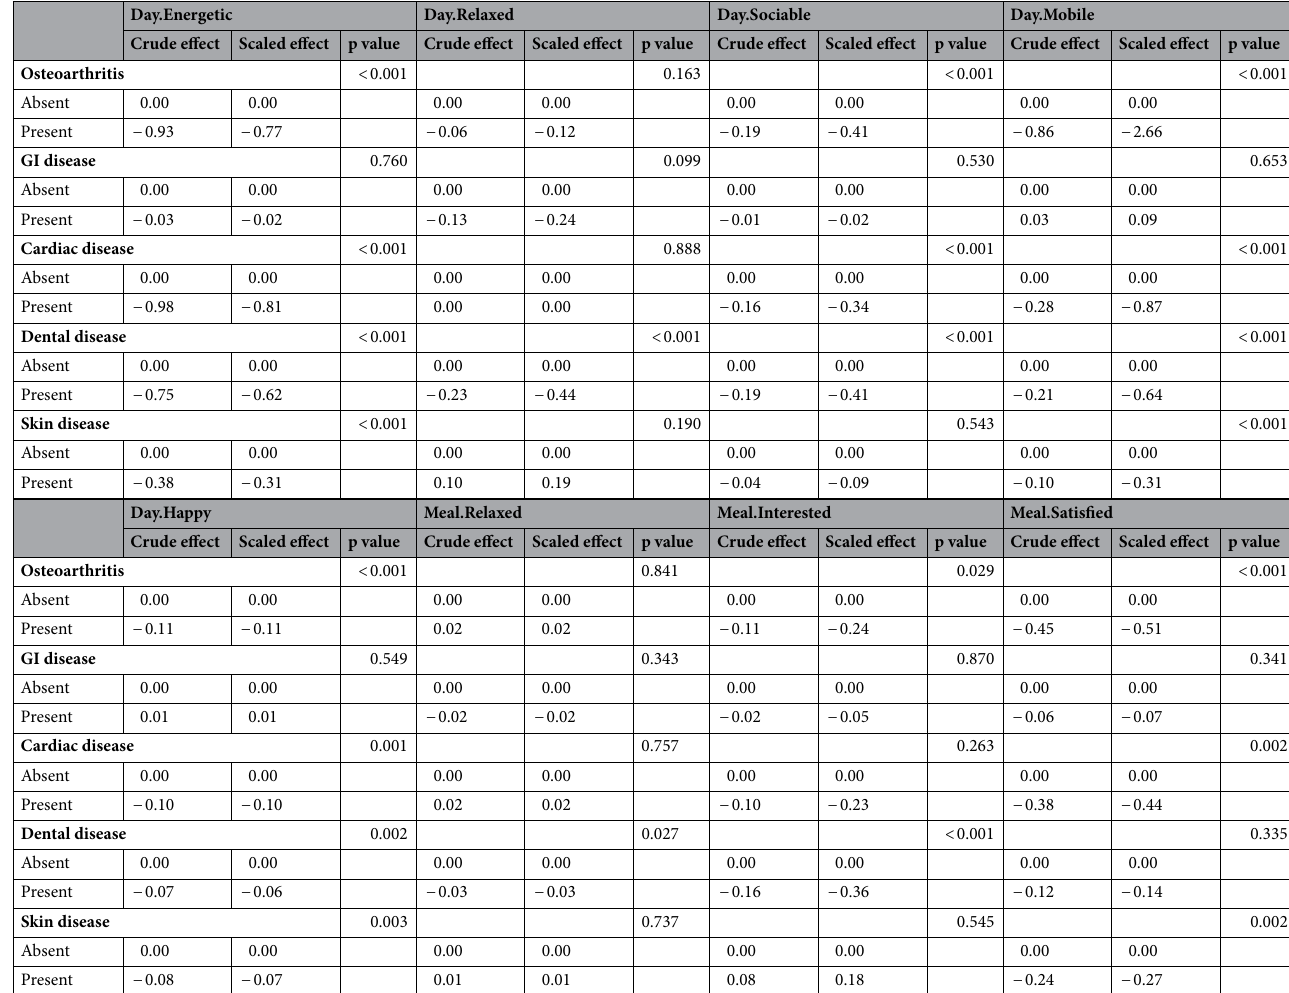
Table 3. Effect of Osteoarthritis, gastro-intestinal (GI) disease, cardiac disease, dental disease, and skin disease on domain scores. Effects are expressed versus a reference category either on the 1 to 7 domain score scale (crude effect) or approximately scaled to the domain score population standard deviation (scaled effect). The present category included 301 dogs for osteoarthritis, 86 for GI disease, 214 for cardiac disease, 608 for dental disease, and 335 for skin